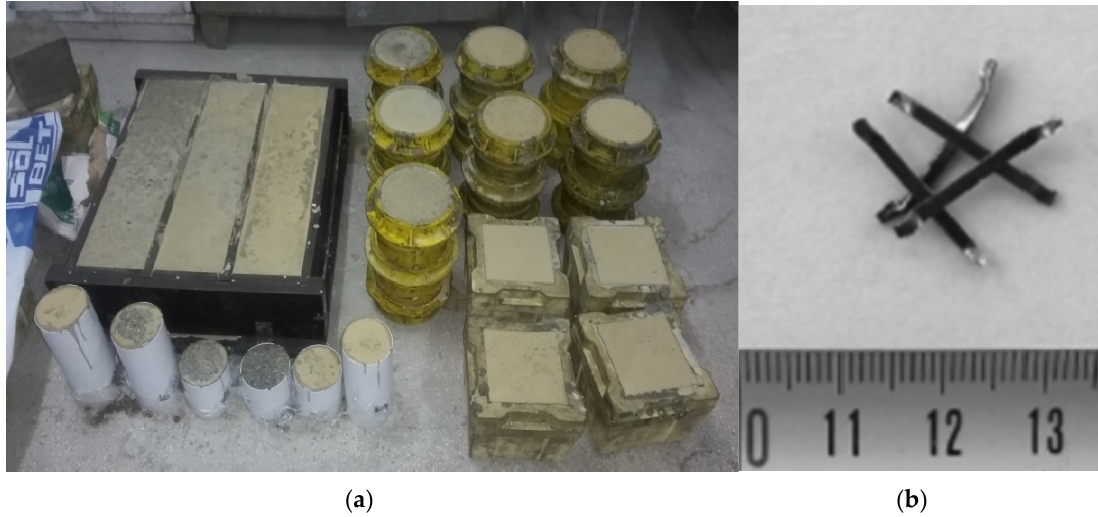
Figure 1. ( a ) Example of preparation of laboratory samples for one set of mixtures; ( b ) Steel fibres KE20/1.7—shape and dimension [31].